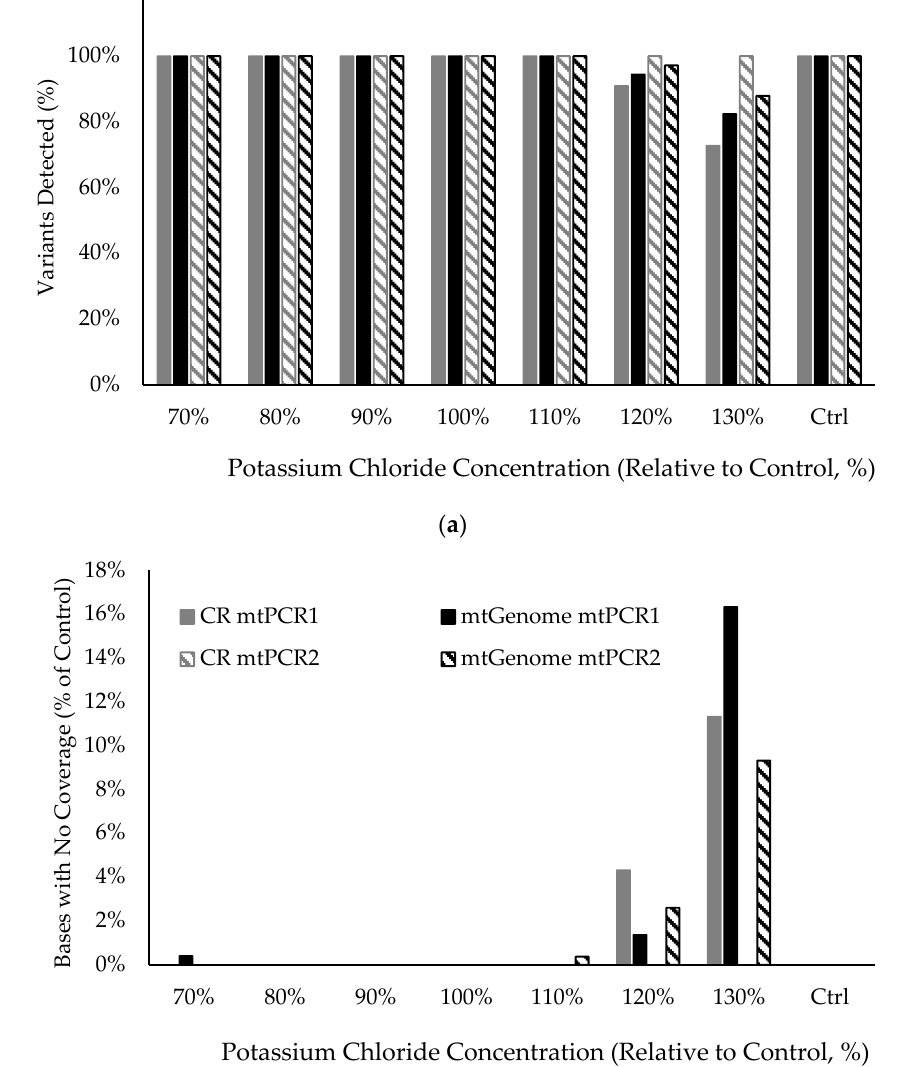
Figure 4. Critical reagents in PCR-based studies: potassium chloride concentration effect on variant detection and coverage in the control region and mtGenome multiplexes. Effects of varied KCl concentrations on the four mtDNA PCR buffers (mtPCR1 and mtPCR2 for each kit; x-axes in ( a ) and ( b )) on variants detected (% relative to total; y -axis in ( a )) and on bases with no coverage (% relative to control; y -axis in ( b )) was assessed using 100 pg of HL60 positive control gDNA. 100% KCl is the titration control, and “Ctrl” is the commercial buffer lot of mtPCR1 and mtPCR2 for both multiplexes. Increased KCl relative to the control, and thus the manufactured standard, can contribute to data loss, as has been reported for forensic PCR systems generally.